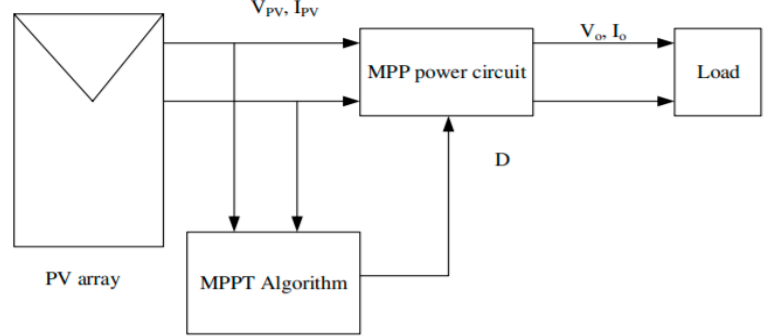
Figure 9. MPPT Control block diagram.